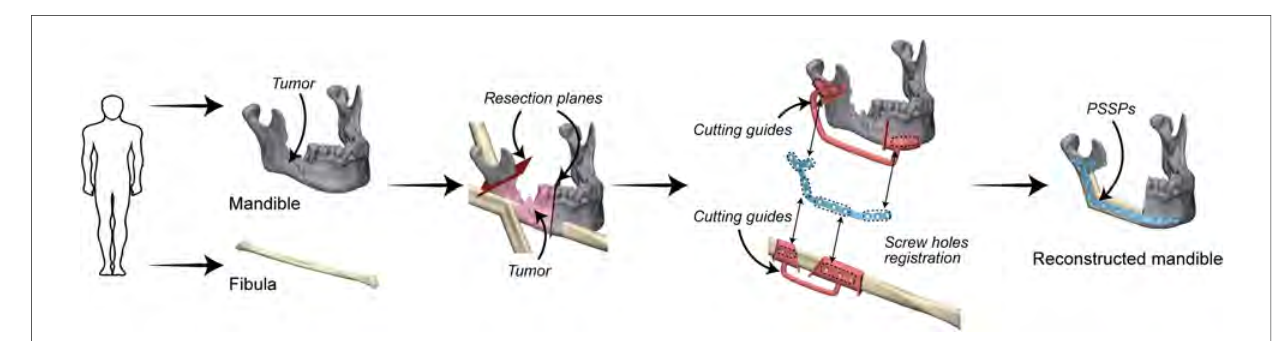
FIGURE 2 Virtual surgical planning and the work fl ow of PSSPs-enhanced CAMR.